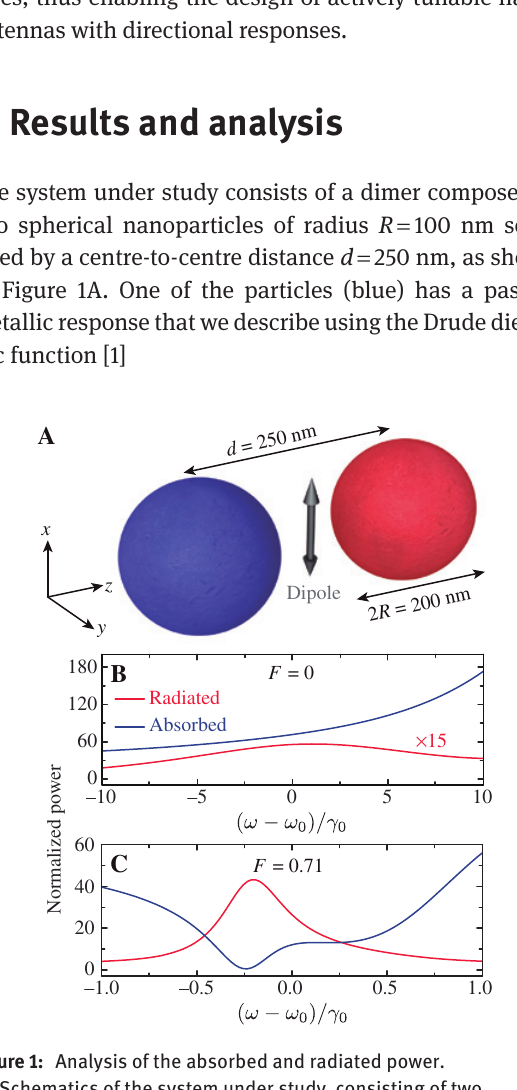
Figure 1: Analysis of the absorbed and radiated power. (A) Schematics of the system under study, consisting of two spherical nanoparticles with a radius R = 100 nm separated by a centre-to-centre distance d = 250 nm, which are excited by a dipole source placed in the centre of their gap. One particle has a conventional passive plasmonic response (blue), whereas the other displays optical gain (red). (B, C) Total power radiated (red curve) and absorbed (blue curve) by the dimer when excited by the dipole. These quantities are normalised to the power radiated by a dipole p 0 = 4 ω 4 | p in vacuum P | 2 /(3 c 3 ). In B, we assume a fully passive dimer 0 0 (i.e. F = 0), whereas in C, the pumping parameter is set to F = 0.71. Notice that in B the red curve is multiplied by 15 to improve